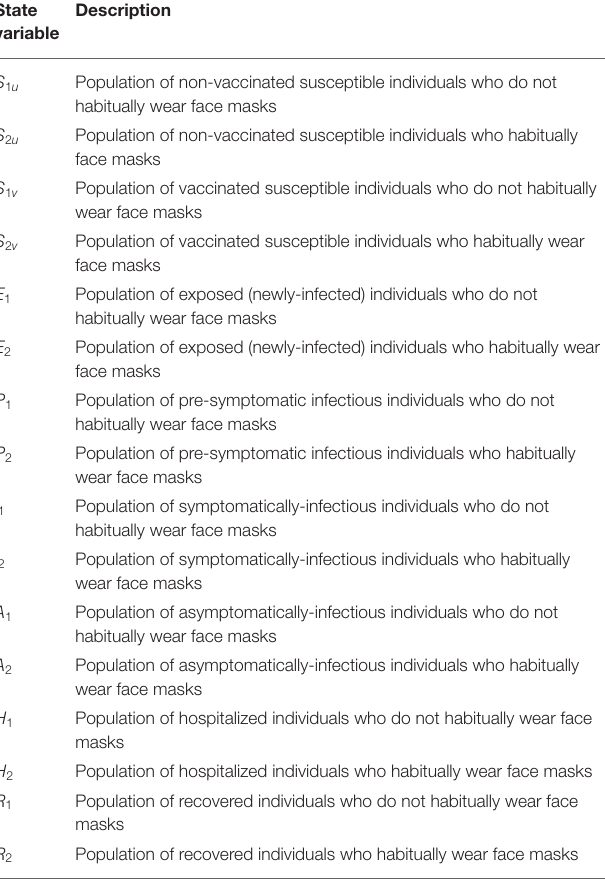
TABLE 1 | Description of the state variables of the model { (2.5),(2.6) } . State Description variable